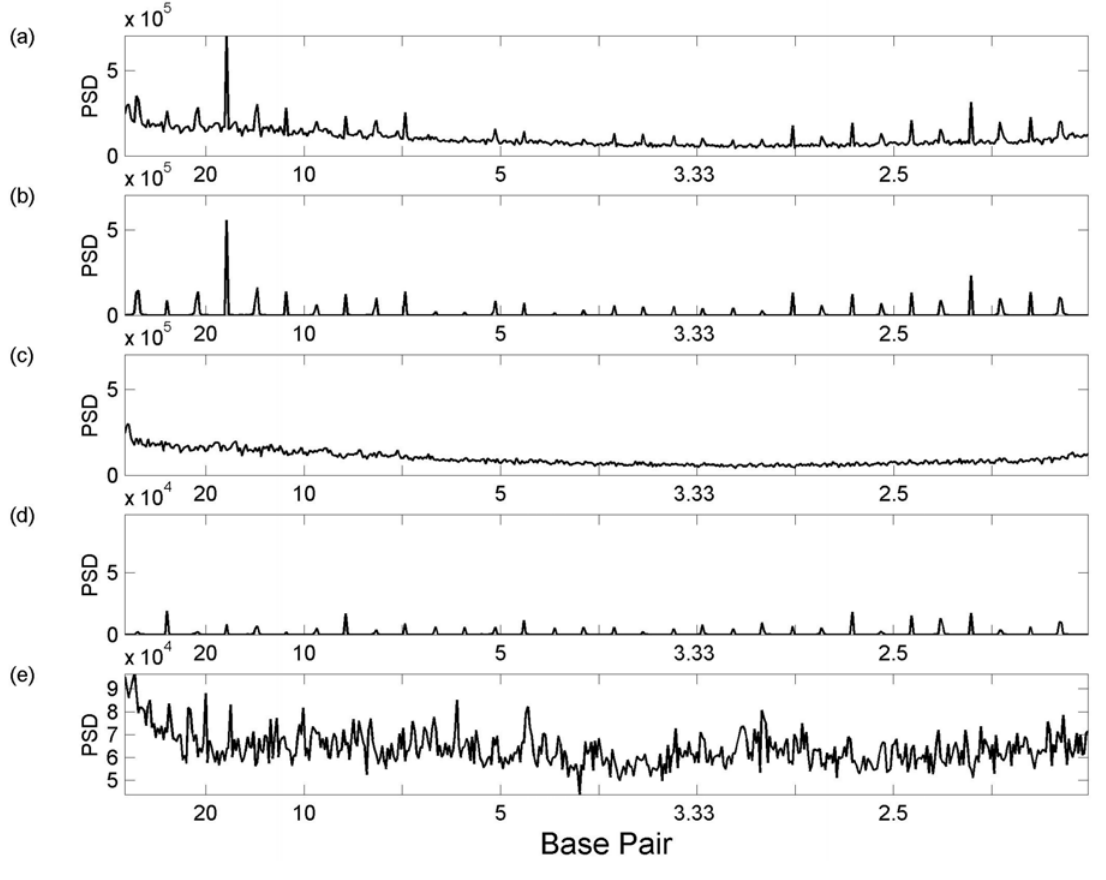
spectra with its occurrence spectra. PSD – Figure 9. Comparison of Sp1 tfbs 76 3 k + Roll spectra for all Sp1 tfbs in chromosome 21; (b) power spectral density. (a) Summed 3 k + Roll spectrum alone; (c) summed Sp1 3 k + spectra omitting tfbs 76 (d) Sp1 tfbs 76 3 k + Roll Roll